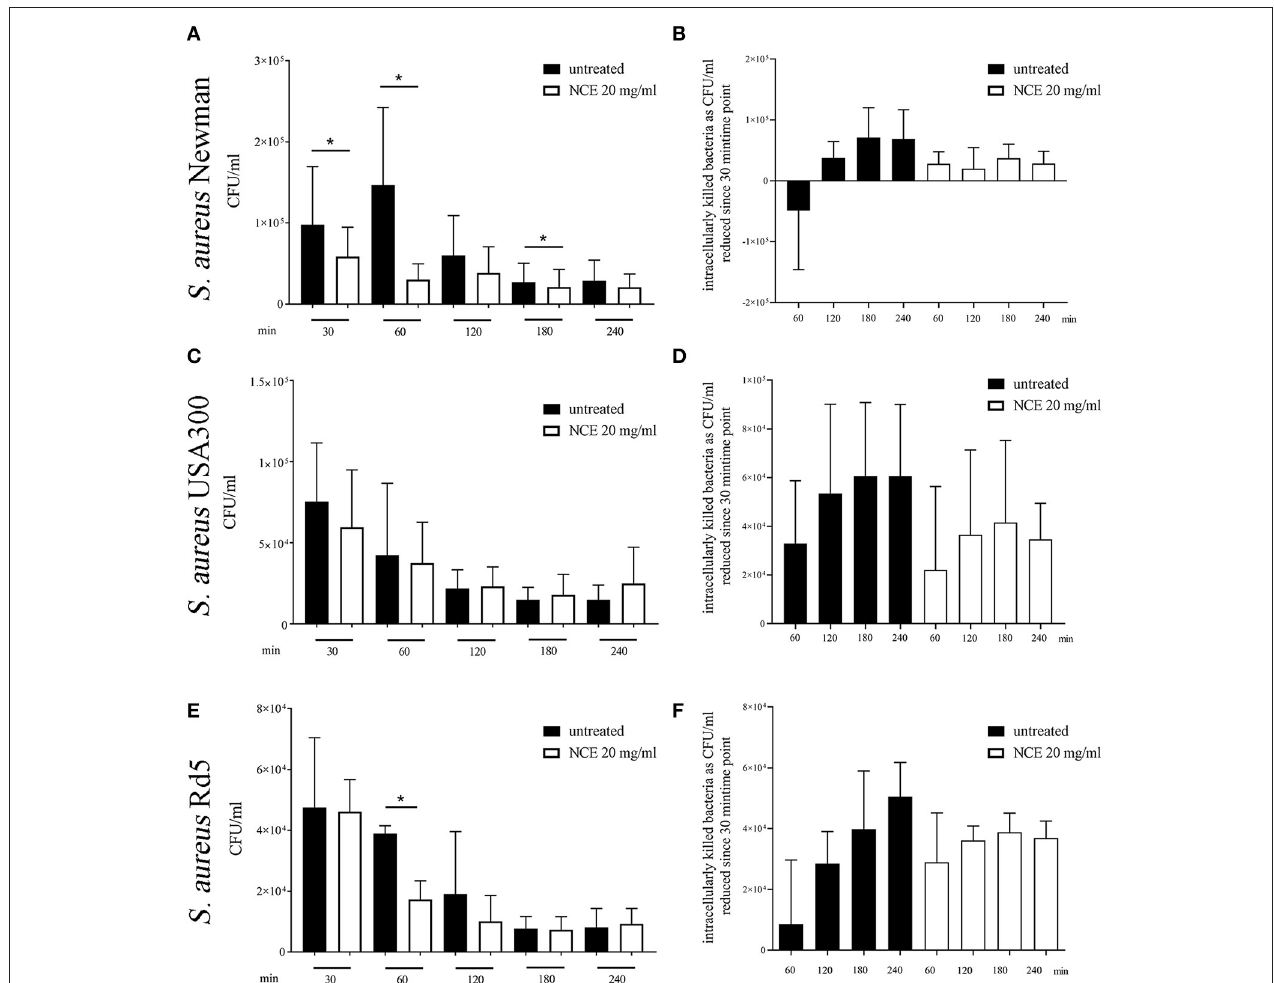
FIGURE 8 | Phagocytosis of S. aureus strains after pre-simulation of bovine and human whole blood with 20mg/ml natural crude extract (NCE). Human or bovine whole blood was pre-treated for 2h with 20mg/ml NCE. Human blood was co-incubated with S. aureus Newman ( A,B ; n = 5) and S. aureus USA300 ( C,D ; n = 5). Bovine blood was co-incubated with S. aureus Rd5 ( E,F ; n = 3). After 30min of co-incubation, extracellular bacteria were killed with gentamicin (A–D) or vancomycin (E,F) . Untreated blood was used as a control. Phagocytosed S. aureus were recovered by plating the samples on blood agar after lysis of the eukaryotic cells. Cells of NCE-stimulated human blood phagocytosed significantly less S. aureus Newman after 30min (A) and the killing of S. aureus Newman was comparable in untreated and NCE-treated blood (B) . Phagocytosis of S. aureus USA300 was not significantly different in untreated and treated human blood (C,D) . NCE stimulation of bovine blood had no effect on the uptake of S. aureus Rd5 (E) , but the killing of intracellular bacteria is remarkably lower after 30min (F) . All data are shown as means ± SD. Statistical analysis was done by one-tailed, paired Student’s t -test. * P < 0.05 was considered